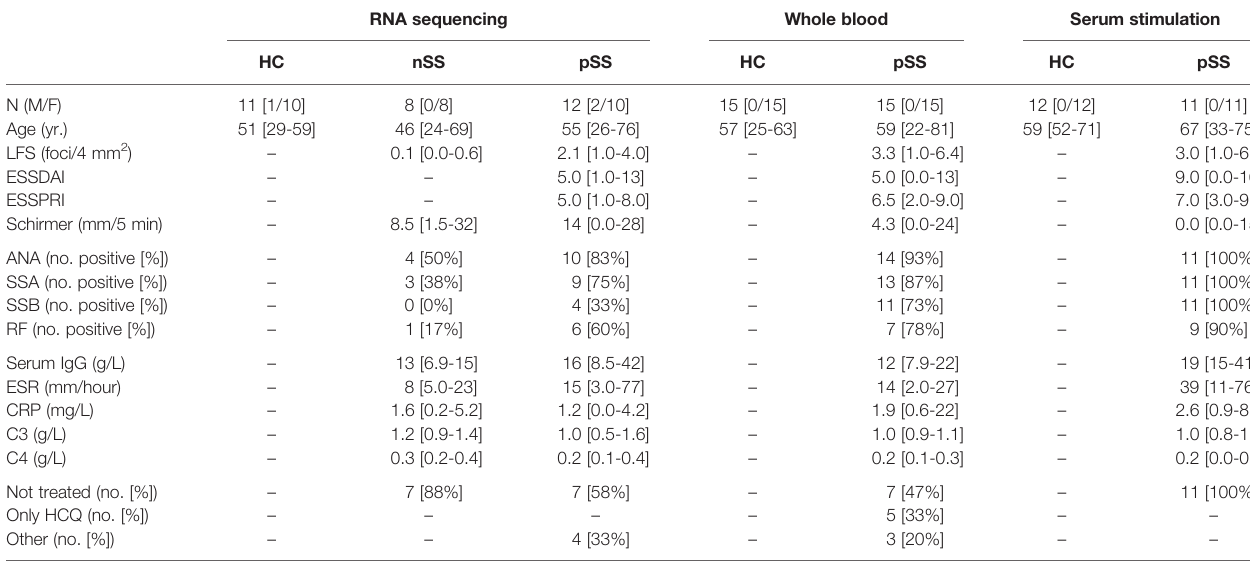
TABLE 1 | Characteristics of the patients and controls enrolled in the study.